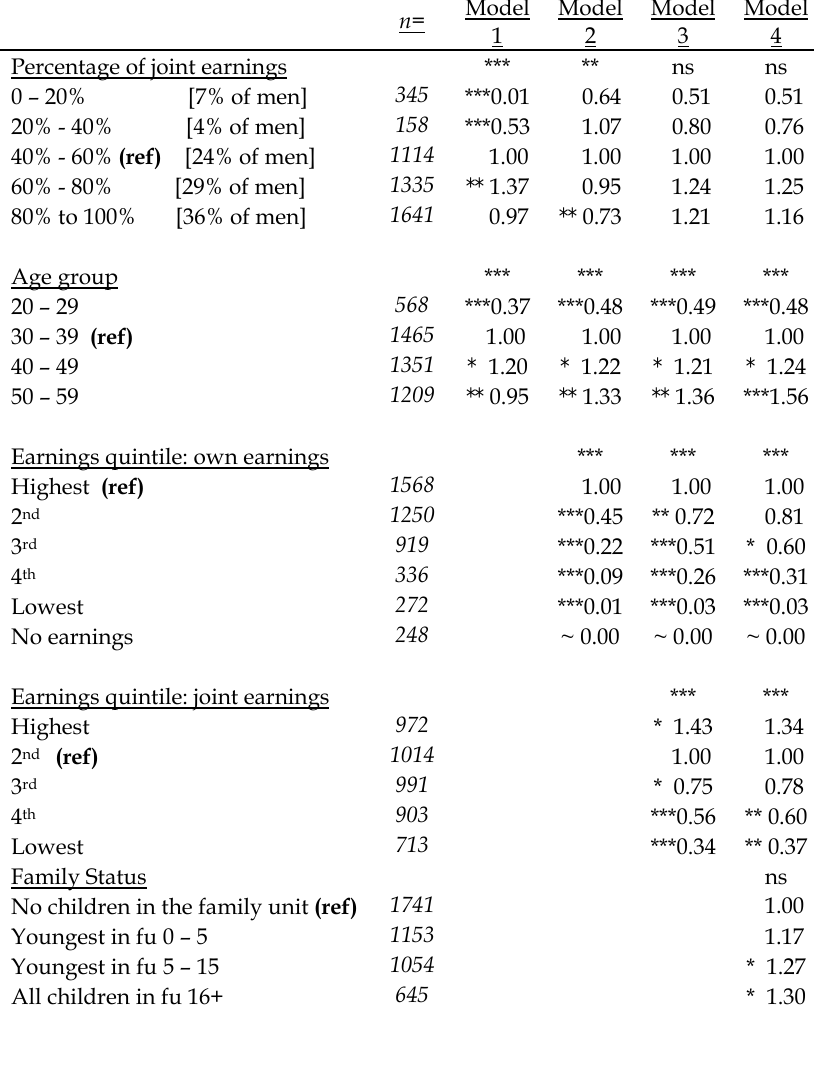
Table 1. Odds ratios for contributing to additional pensions,